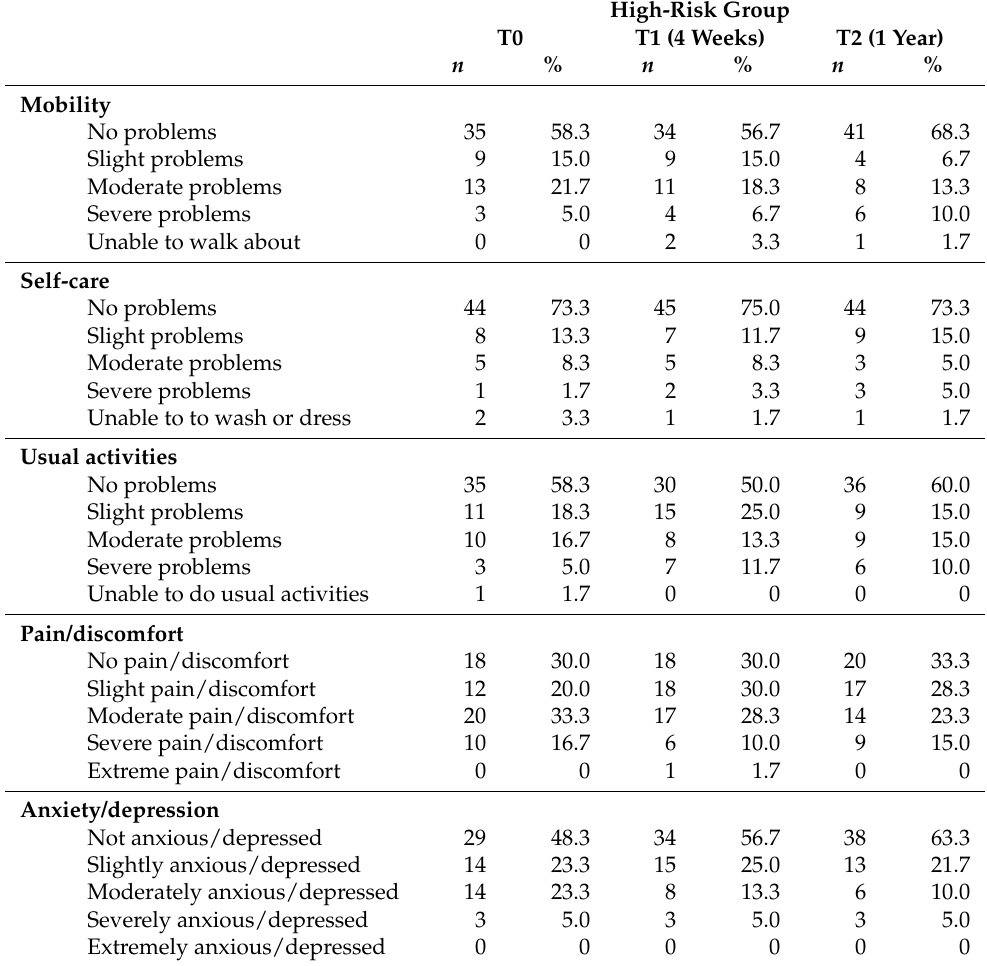
Table 2. Results of EuroQol Group’s EQ-5D instrument (EQ-5D) for high-risk group.